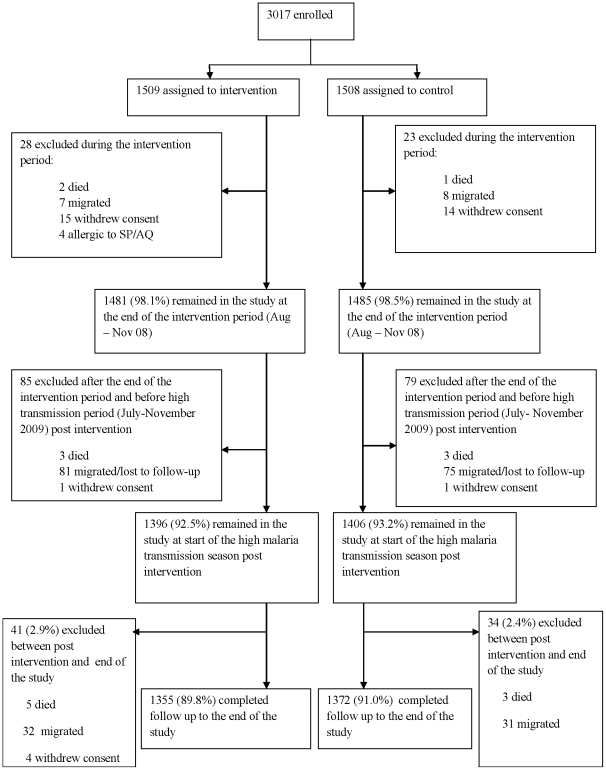
Study flow chart.